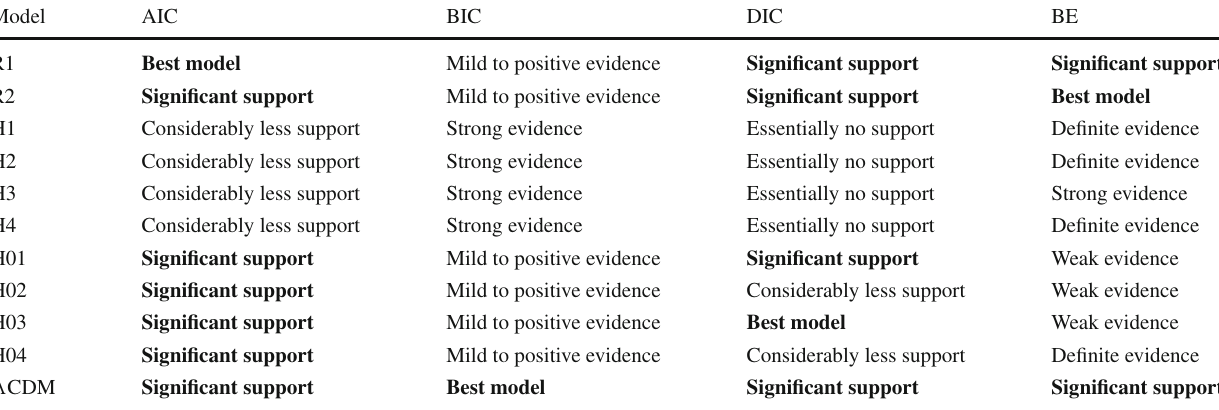
Table 7 The support to (respectively, evidence against) a given DE model obtained using the results of different information criteria and Bayesian evidence (BE)